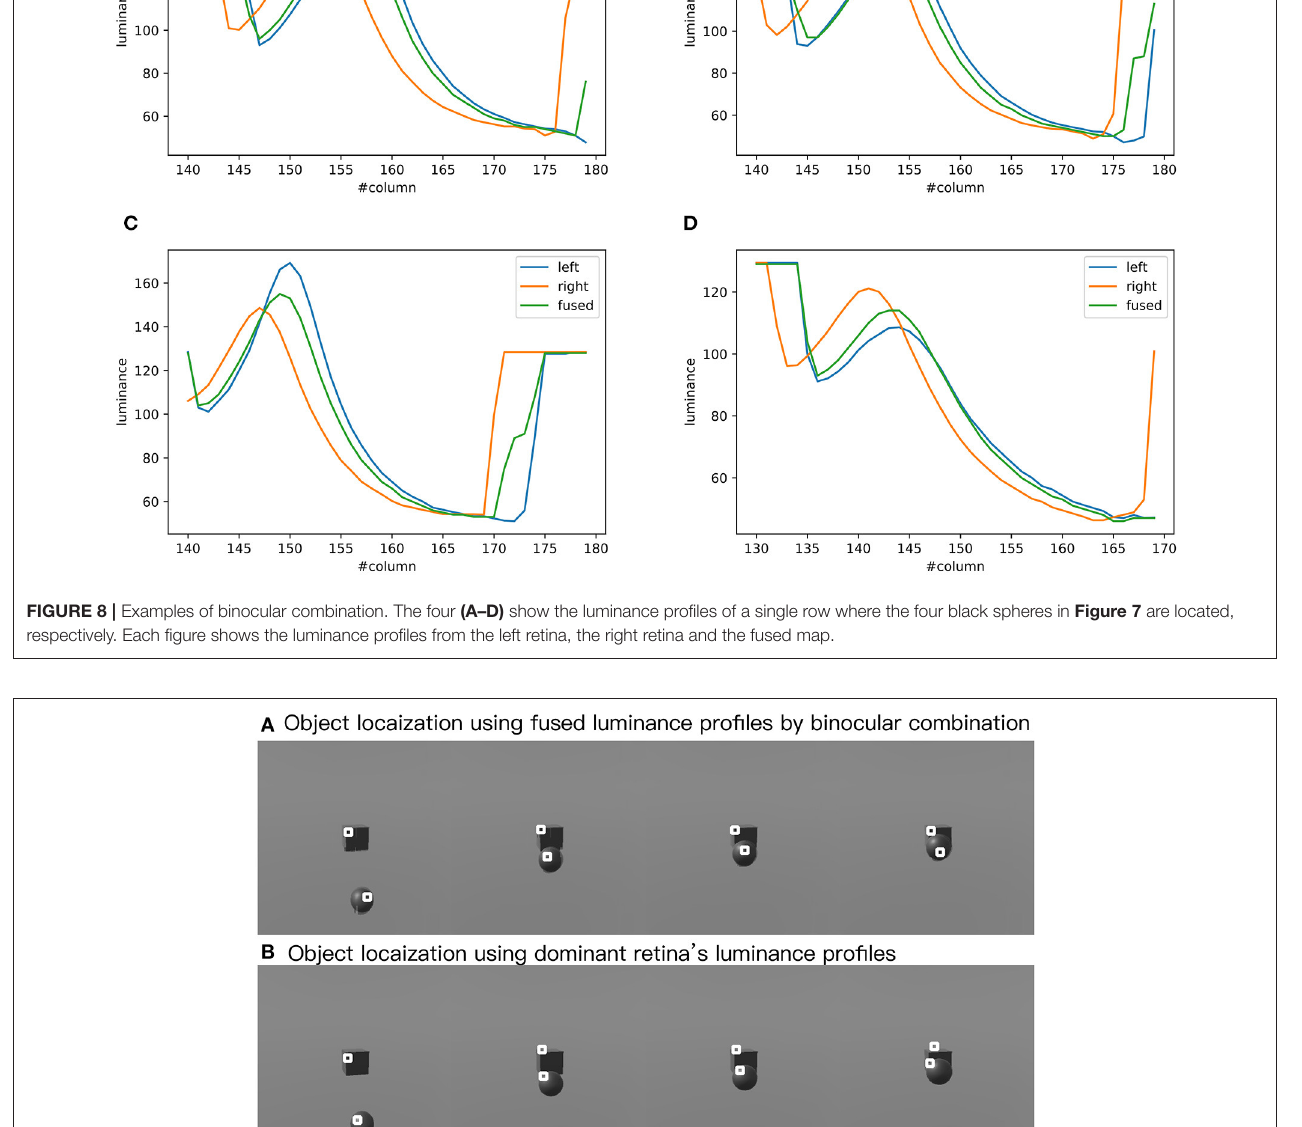
As an example, Mahoor reported a median Euclidean